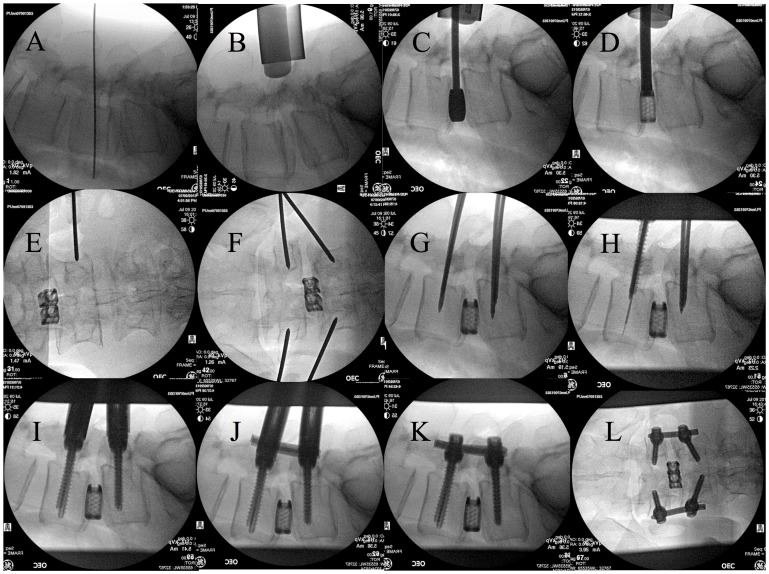
Utilization of fluoroscopy.Fluoroscopy was typically involved at 5 steps during MIS-TLIF: preoperative skin marking (A), confirmation of the retractor position (B), placement of the cage (C, D), insertion of the percutaneous pedicle screws (E–I), and placement of the rods (J–L). We used one-shot imaging, which uses short exposure times rather than continuous exposure.